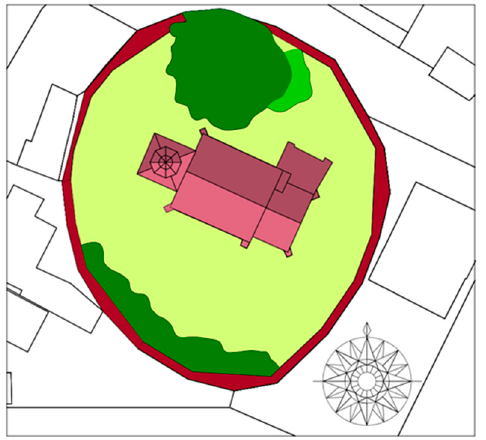
Figure 2. Top view as an illustration with the surrounding vegetation.